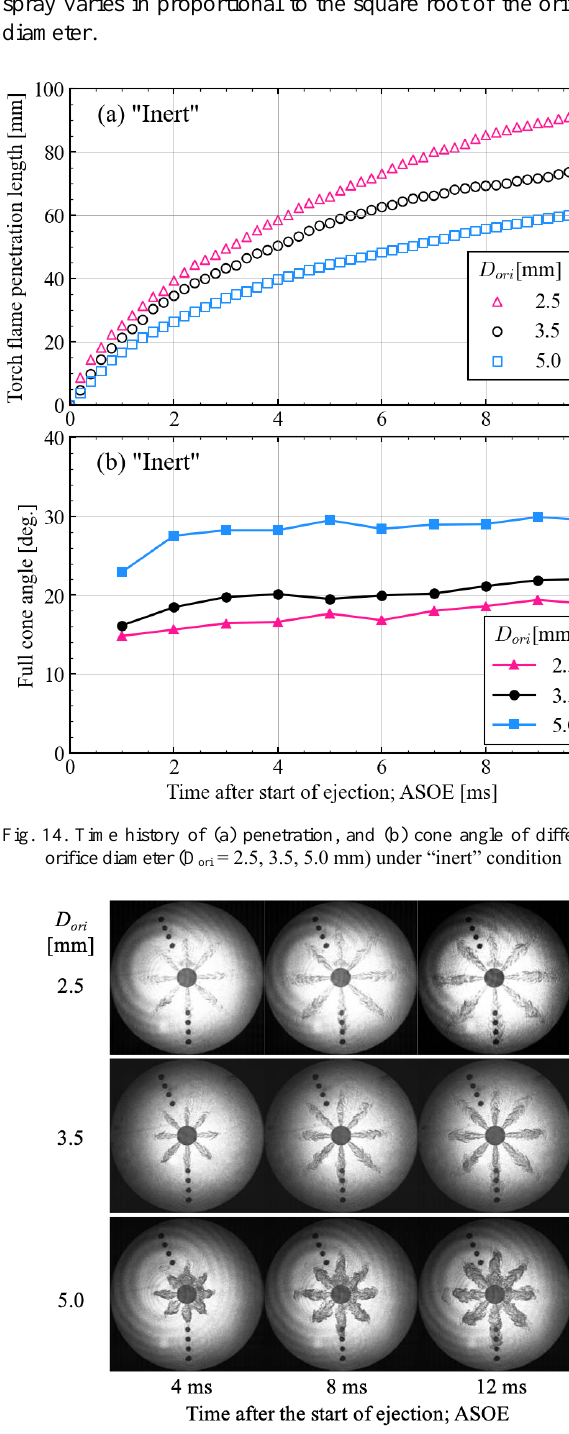
Fig. 15. Shadowgraphs of different orifice diameter (D ori = 2.5, 3.5, 5.0 mm) under “inert” condition The ratio of the square root of the orifice diameter is 1: 1.18: 1.41, and the ratio of the corresponding penetration length from the center of the PC is 76.6 mm (1): 89.4